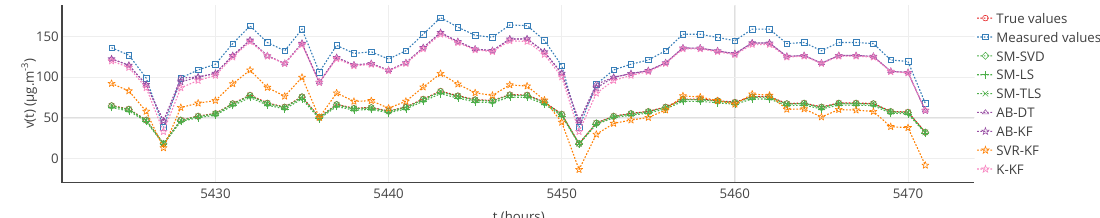
Figure 6. True values, measured values and corrected values with the strategies considered for a particular sensor s 1 = 2 between t = 5424h and t = 5471h. SM-(SVD, LS, TLS) and SVR-KF seem to provide better results than AB-DT, AB-KF and